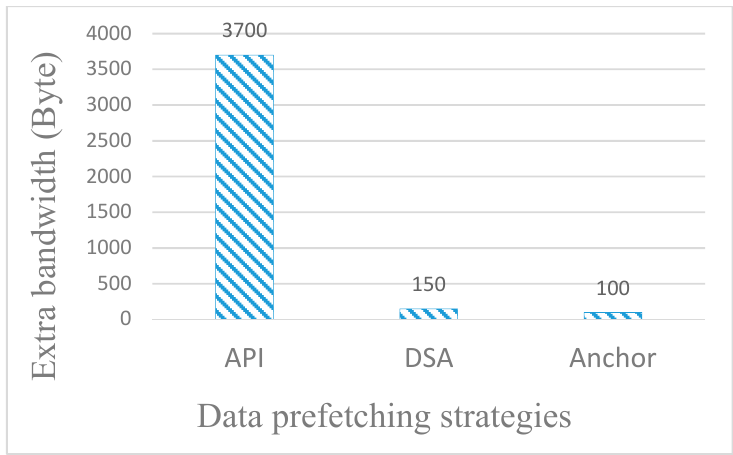
Figure 8. Extra bandwidth consumption of different strategies.